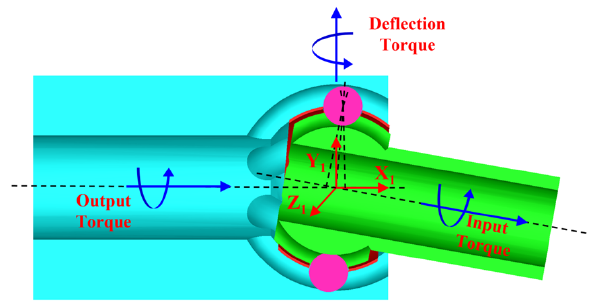
Figure 14. Schematic diagram of deflection torque.